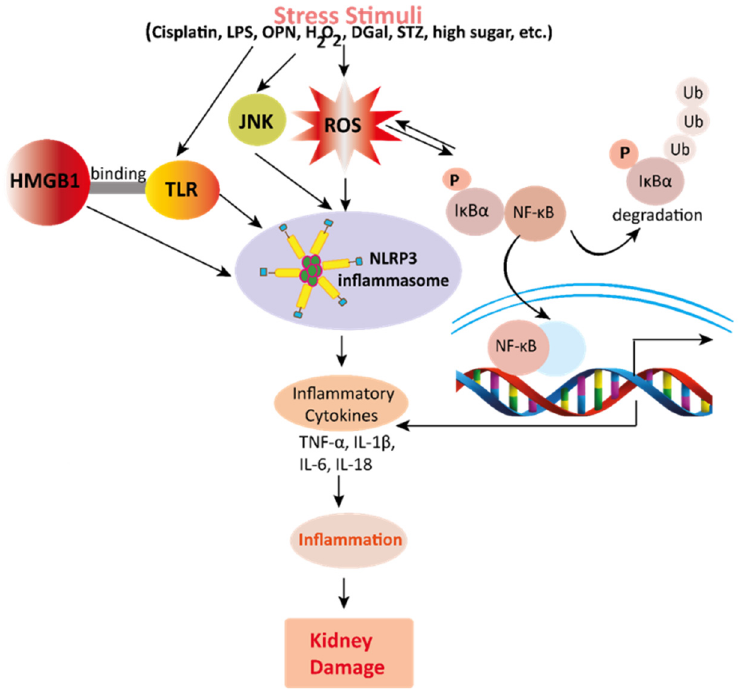
Figure 3. Mechanisms involved in the pathogenesis of inflammation in the kidney. Stress stimuli example for, cisplatin, DGal, STZ, LPS, OPN, high glucose, and H 2 O 2 generate ROS in the kidney. Accumulation of ROS induces inflammation through the activation of the NLRP3 inflammasome. NLRP3 involves a multi-protein complex known as inflammasome, which triggers the NF- κ B sig- naling pathway. HMGB1 protein is a late inflammation instigating compound which activates the NF- κ B signaling pathway by binding with Toll-like receptors. The NF- κ B pathway further promotes an inflammatory storm by releasing inflammatory cytokines (TNF- α , IL-1 β , IL-6, IL-18), which ultimately leads to kidney damage. High-mobility group box 1; HMGB1, D (+) galactosamine; DGal, osteopontin; OPN, Streptozotocin; STZ, reactive oxygen species; ROS, IL-6; interleukin-6, IL-1 β ; Interleukin 1 β , TNF α ; Tumor Necrosis Factor- α